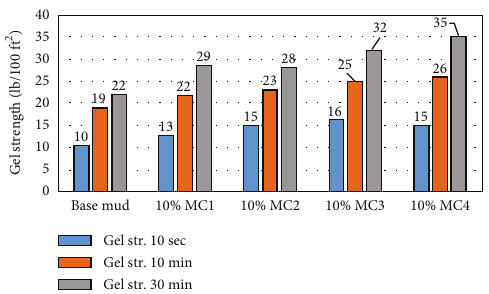
Figure 9: Gel strengths as function of adding 10% of di ff erent cuttings to the base